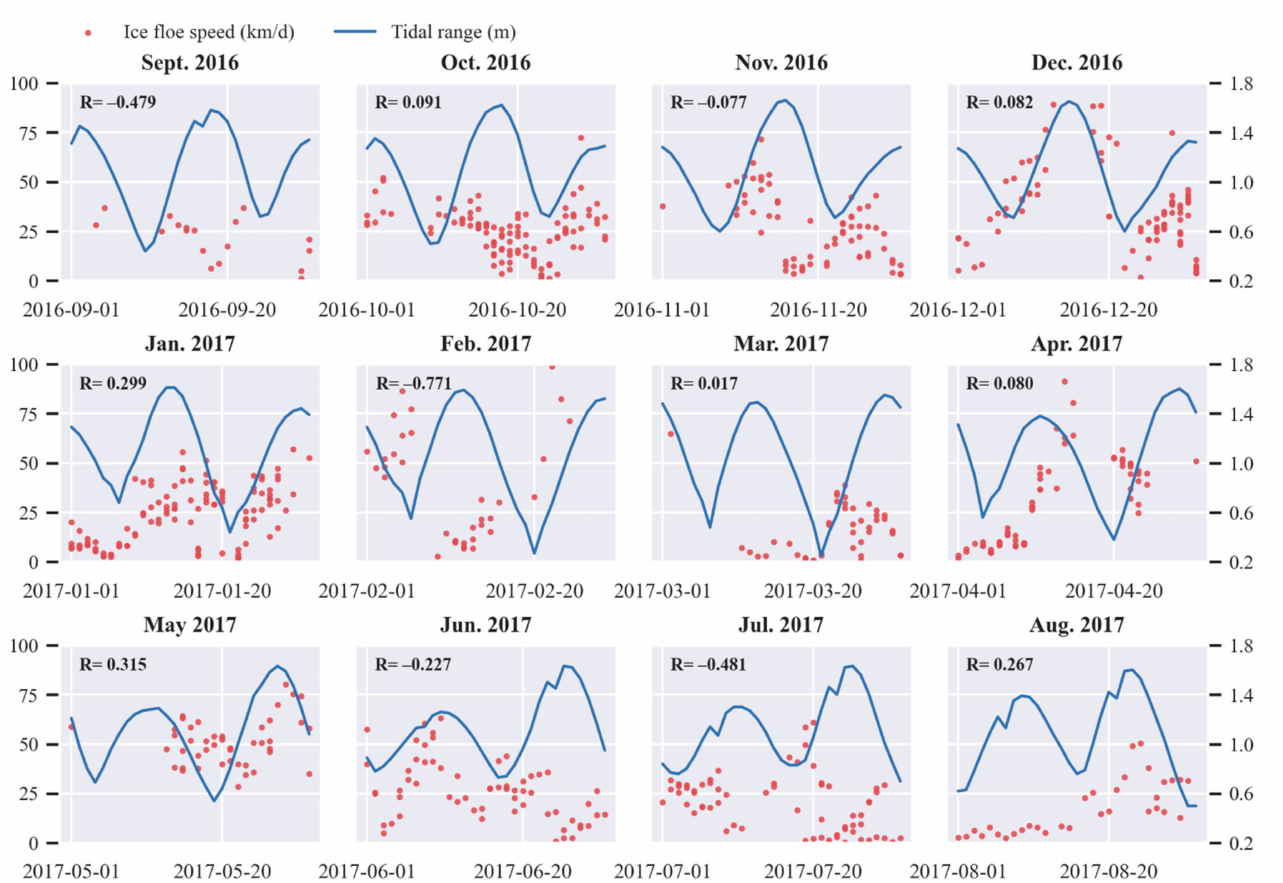
Figure 11. Daily tidal range and ice floe speed from Sentinel-1 images inside the Robeson Channel